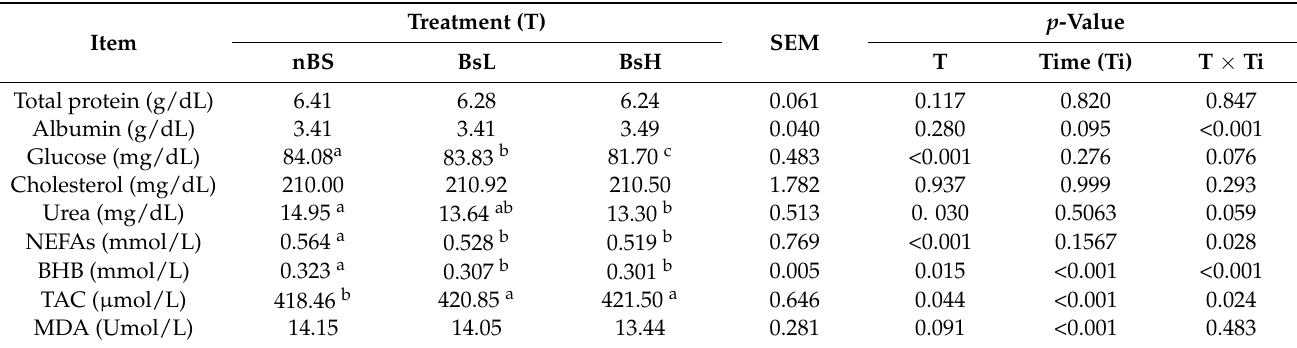
Table 3. Blood plasma metabolites for transitioning goats that received 0 (nBs), 2 (BsL), and 4 (BsH) g of Boswellia sacra resin daily from week 2 prepartum to week 7 postpartum.